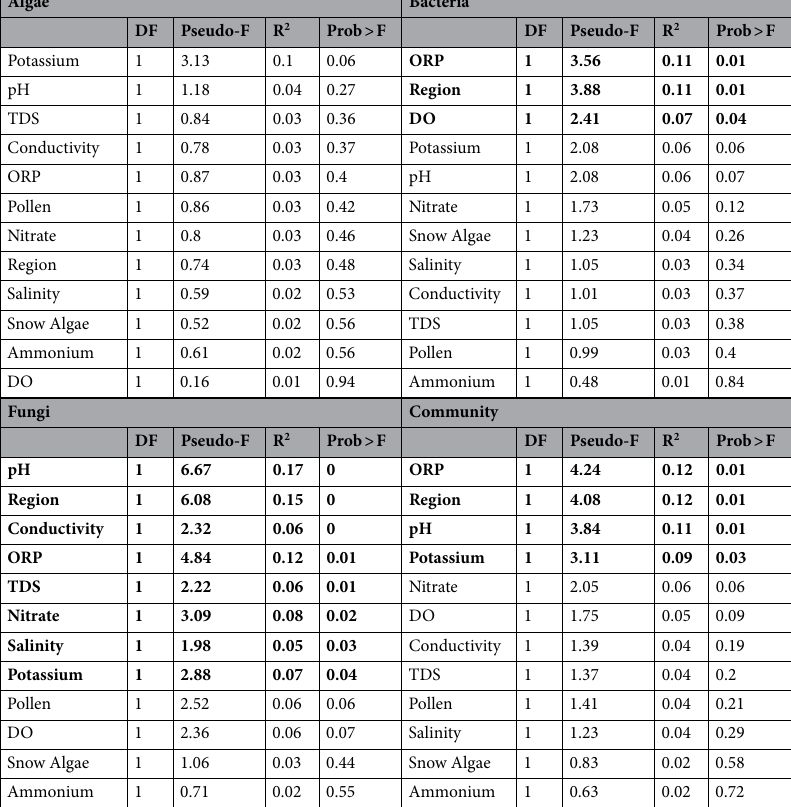
Table 3. PERMANOVA values for environmental traits of algal, bacterial, fungal, and community taxonomic groups. Bolded features were found to be significant (p < 0.05). Significant values are in [ bold ]